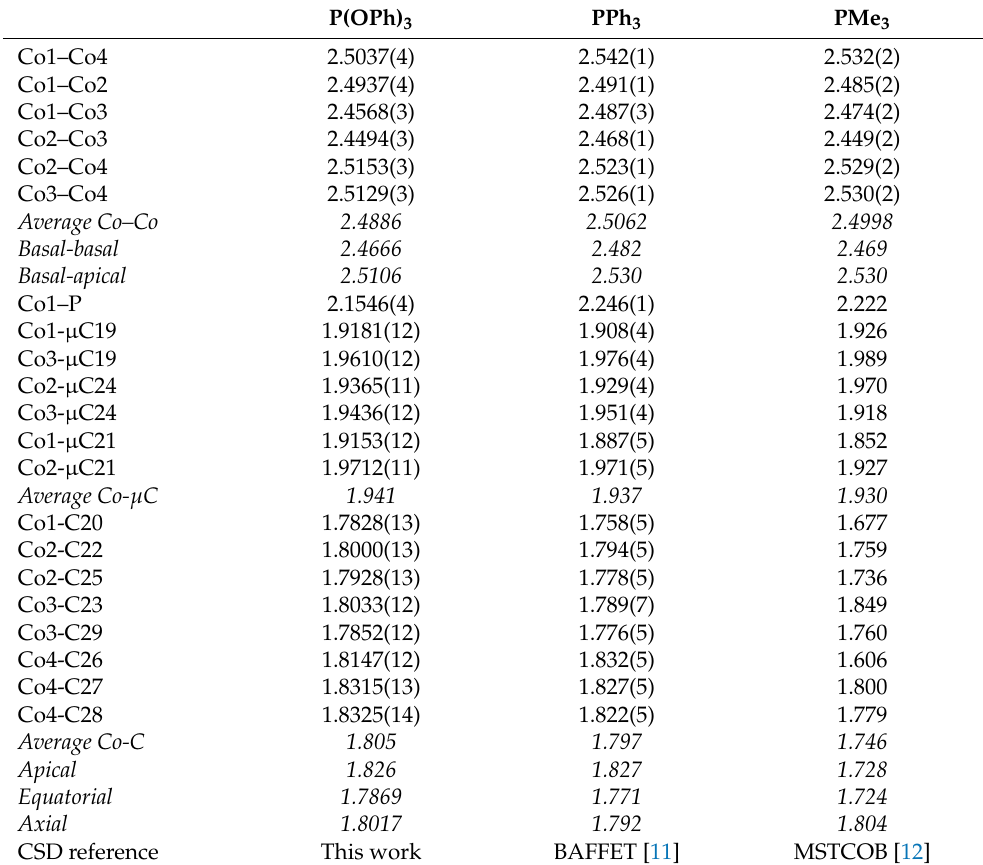
Table 1. Relevant bond lengths (Å) in 2 and crystallographically characterized monosubstituted [Co 4 ( µ 2 -CO) 3 (CO) 8 (PR 3 )]